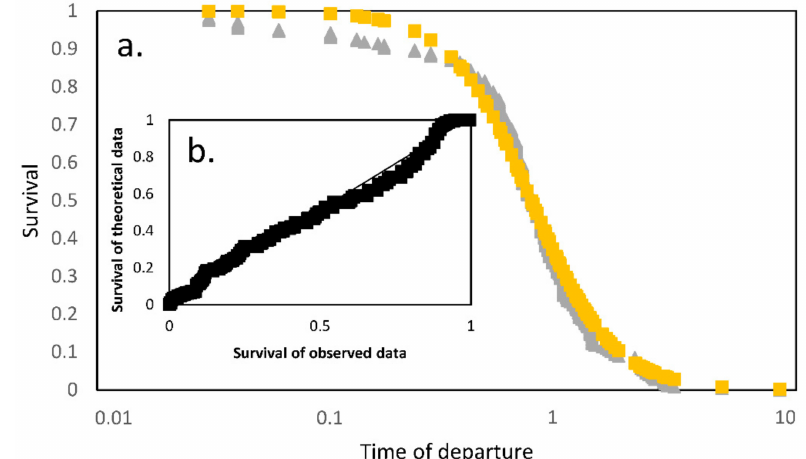
Figure 4. ( a ) Survival analysis of departure time (as log. scale(s)) at the green light for the observed data (grey) and for the theoretical data (yellow); ( b ) Survival values of theoretical data compared to survival values of observed data. The thin black line represents the correlation we should observe between the two survival values if the rule underlying the departure of a pedestrian follows only one rule (here, a sigmoid curve, Equation (1)). For Figure 4a, 0 (1; as log scale) indicates the time at which the light turns